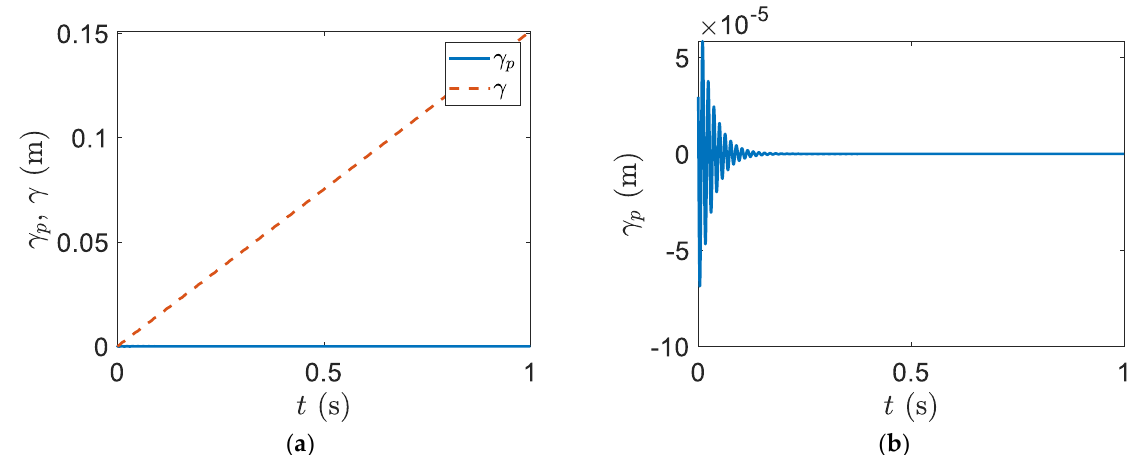
Figure 7. The smart blade system responses of the rotational displacement: (a) the rotational displacement of smart and regular blades; (b) the rotational displacement of smart blade.